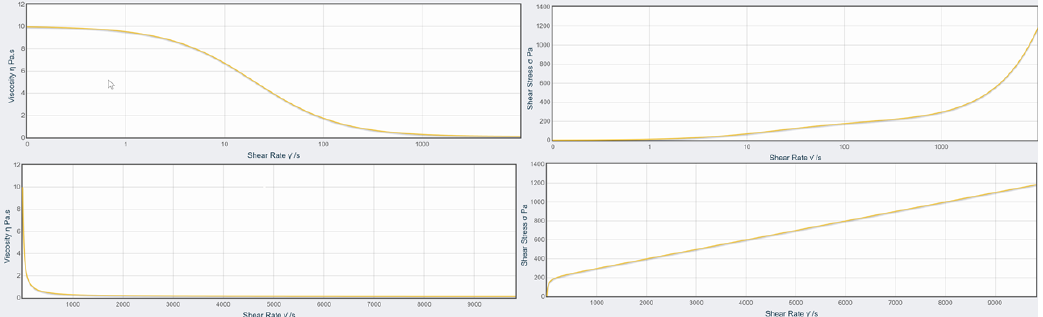
Figure 7. Only an expert could work out that these are the same data plotted with four different options. The x-axis is always shear rate, as log along the top and linear along the bottom. The left-hand plots are of viscosity, the right-hand are of shear stress. The app allows the user to view the same data with a total of six plot options and is at www.stevenabbott.co.uk/practical-rheology/Shear-Viscosity.php.